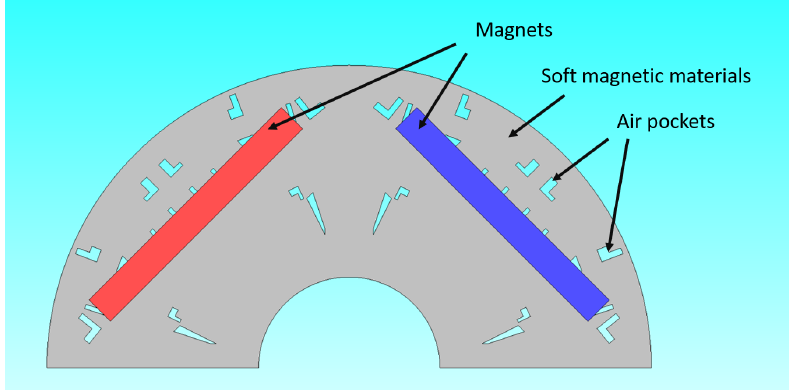
Figure 14. Example of magnetic-based topology optimization for the rotor core of an interior permanent magnet synchronous machine, adapted from [77]. Iron regions adjacent to air pockets and magnets can be subjected to high mechanical